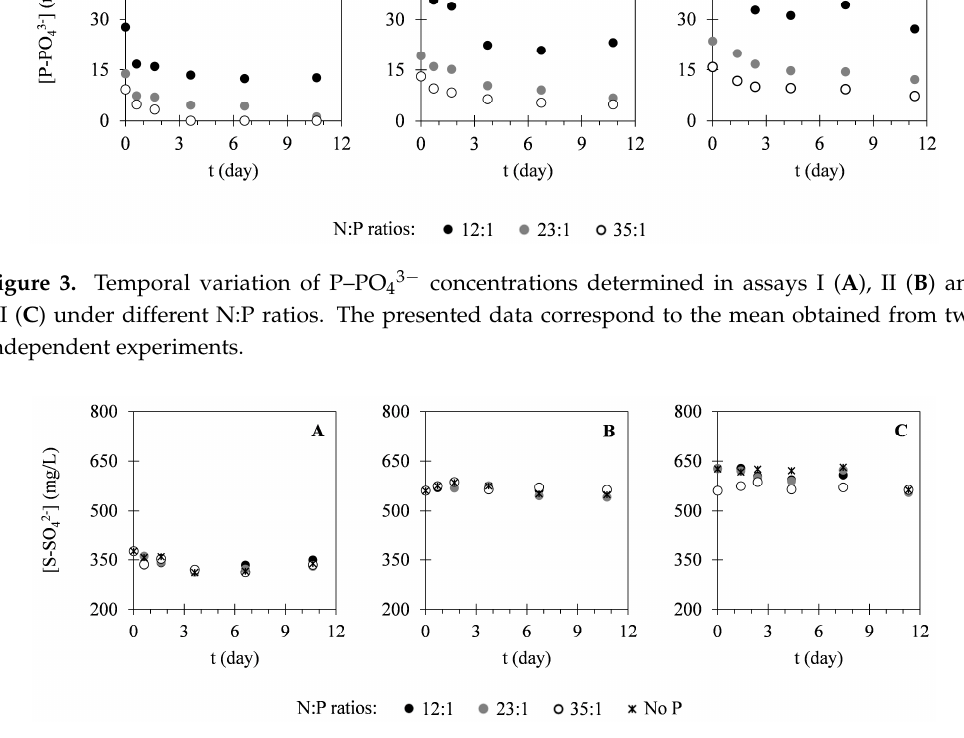
Figure 4. Temporal variation of S–SO 4 2 − concentrations determined in assays I ( A ), II ( B ) and III Figure 4. Temporal variation of S–SO 42 − concentrations determined in assays I ( A ), II ( B ) and III ( C ) Figure 4. Temporal variation of S–SO 42 − concentrations determined in assays I ( A ), II ( B ) and III ( C ) Figure 4. Temporal variation of S–SO 42 − concentrations determined in assays I ( A ), II ( B ) and III ( C ) ( C ) under different N:P ratios. The presented data correspond to the mean obtained from the two under different N:P ratios. The presented data correspond to the mean obtained from the two under different N:P ratios. The presented data correspond to the mean obtained from the two under different N:P ratios. The presented data correspond to the mean obtained from the two independent independent experiments. independent experiments. independent experiments.